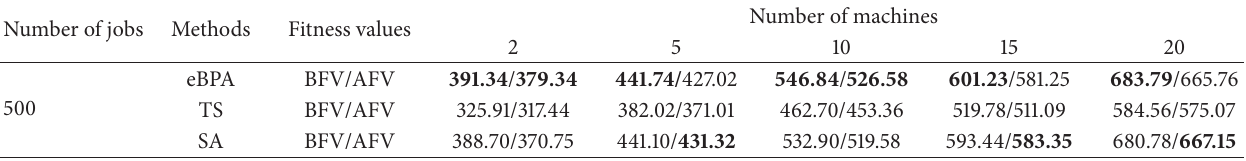
Table 1: Statistics of the best fitness values (BFV) and average fitness values (AFV) for the class of 500 jobs. Number of jobs